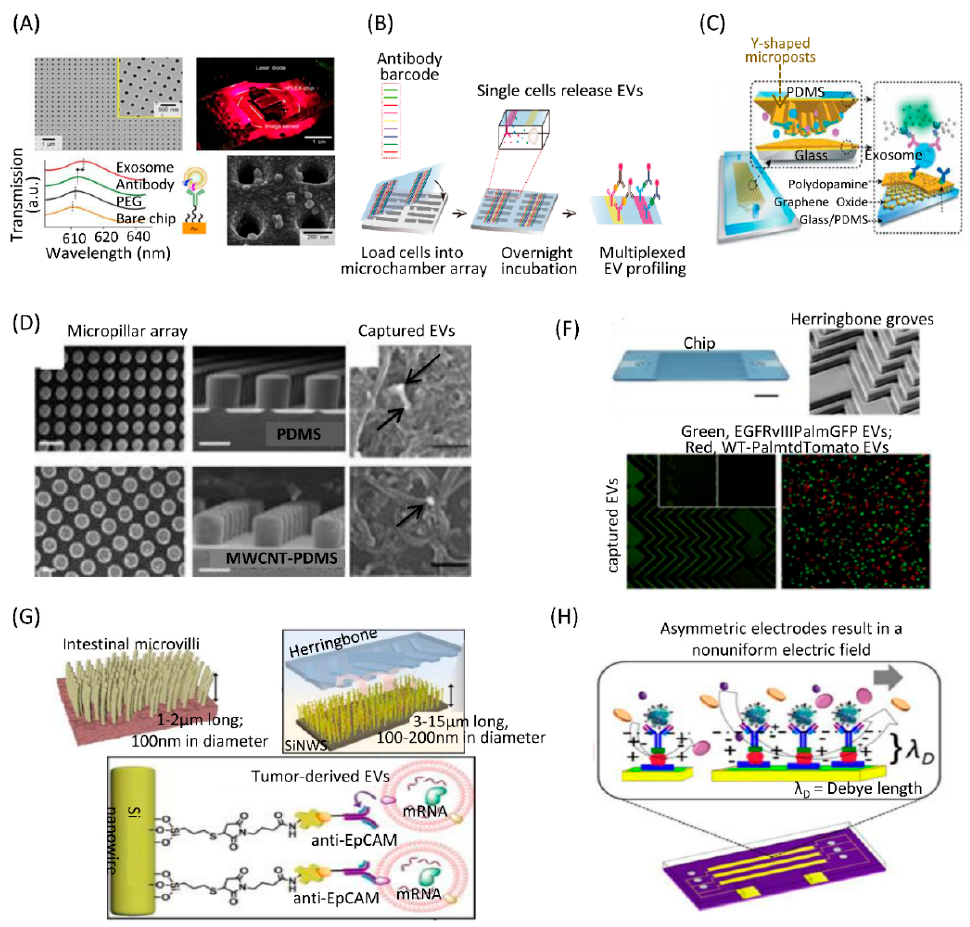
Figure 2. Immunoaffinity separation via solid surfaces on microfluidic chips. ( A ) Label-free Figure 2. Immunoa ffi nity separation via solid surfaces on microfluidic chips. ( A ) Label-free detection of immunocaptued EVs with the nPLEX sensor. Reprinted with permission [60]. Copyright